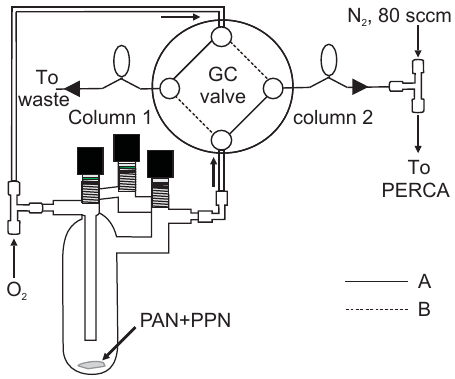
Figure 2. Setup for delivery of PAN and PPN using a gas chro- matography